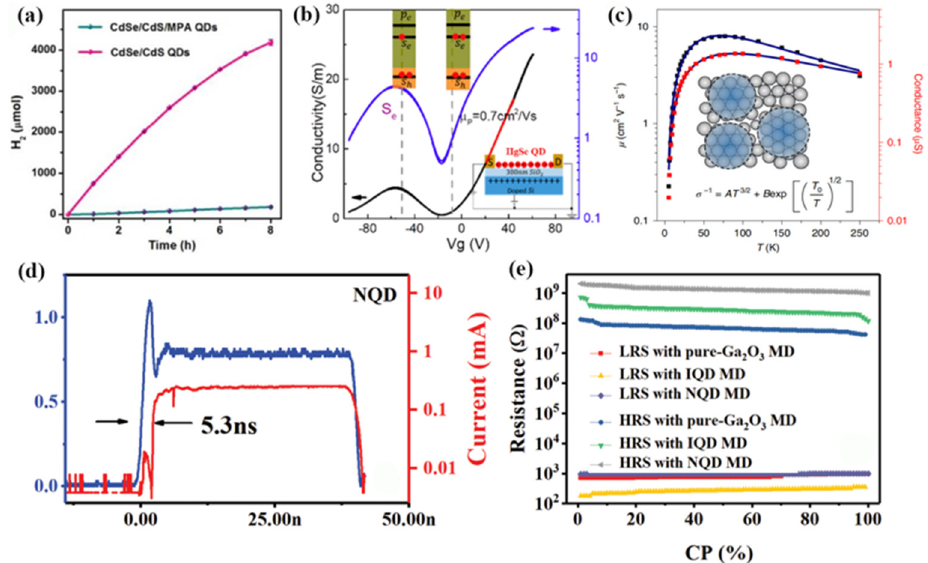
Figure 14. ( a ) Photocatalytic H 2 evolution of CdSe/CdS QD/Pt nanoparticles with and without self-assembly [74]. Copyright 2017, Journal Of The American Chemical Society . ( b ) Field-effect transistor source-drain current of the HgSe hybrid QDs at 80 K [76]. Copyright 2020, The Journal of Physical Chemistry Letters . ( c ) Fitting images of temperature-dependent mobility and conductivity of HgTe QDs solids [77]. Copyright 2020, Nat Mater . ( d ) SET response time for PbS QDs memristor devices. ( e ) Statistic data of resistance distribution for sweeping over 60 I–V cycles [79]. Copyright 2019, Adv Mater.